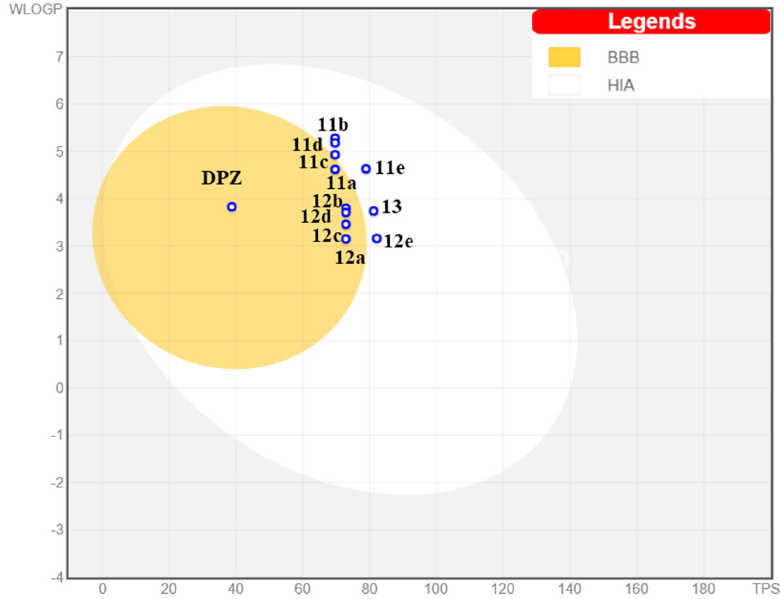
Figure 6 . Prediction of pharmacokinetic properties of compounds 11a – e , 12a–e and 13 according to BoiledEgg. BBB = blood–brain barrier permeation; HIA = human intestinal BoiledEgg. BBB = blood–brain barrier permeation; HIA = human intestinal absorption. Further pharmacokinetic features were predicted by QikProp v.2.5 [46]. In particular,